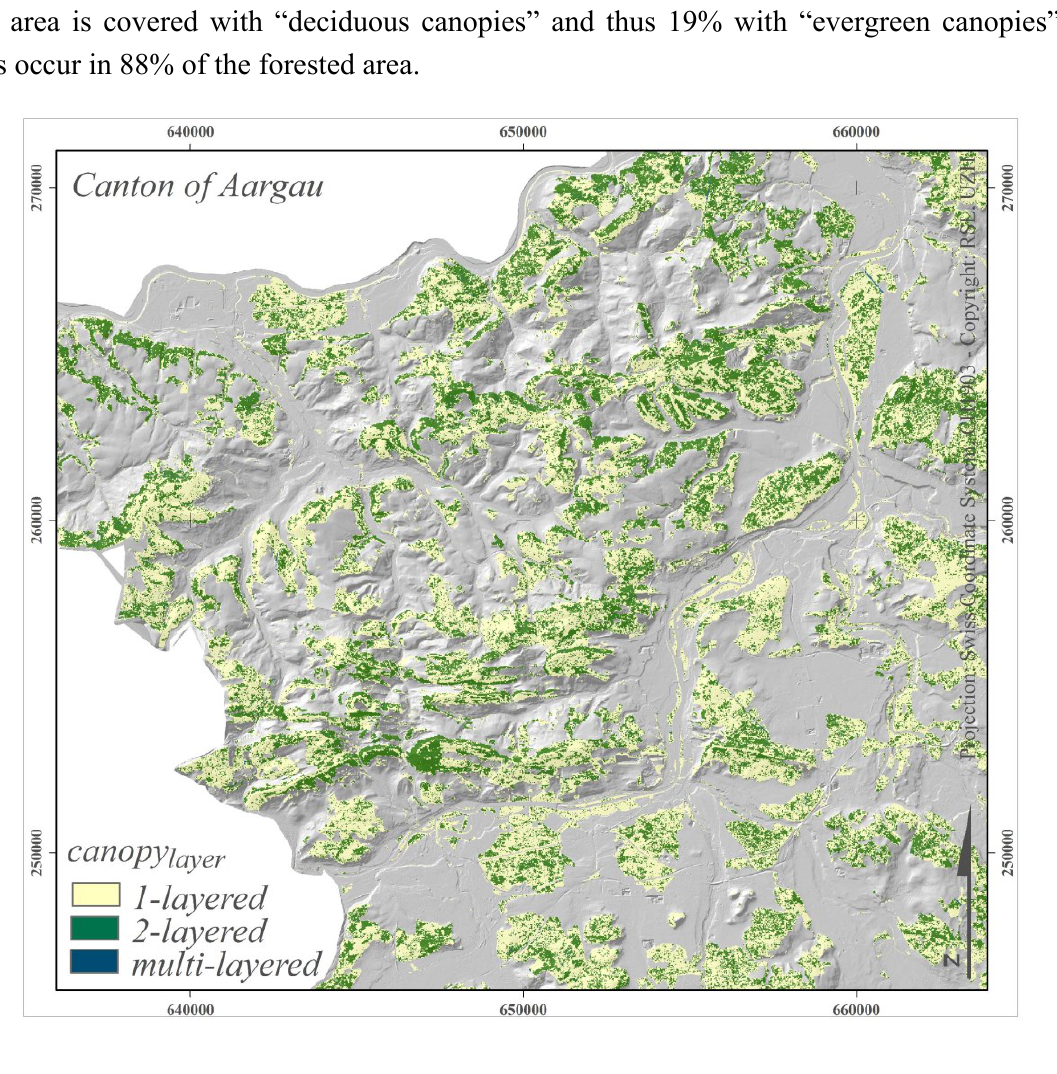
Figure 5. Canopy layering ( canopy layer ) scaled to a larger part of Canton of Aargau. Background data are from a hill-shaded digital terrain